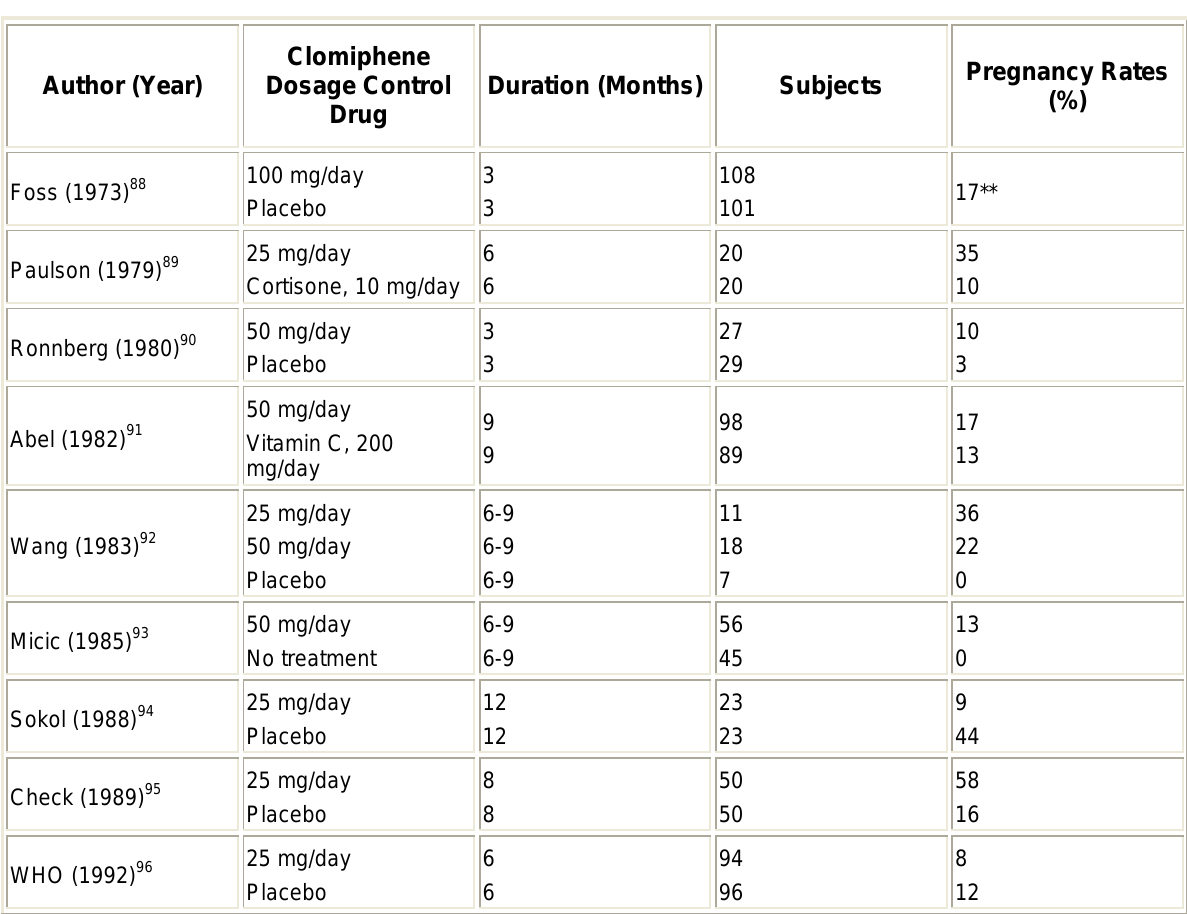
Controlled Studies of Clomiphene Citrate as Empiric